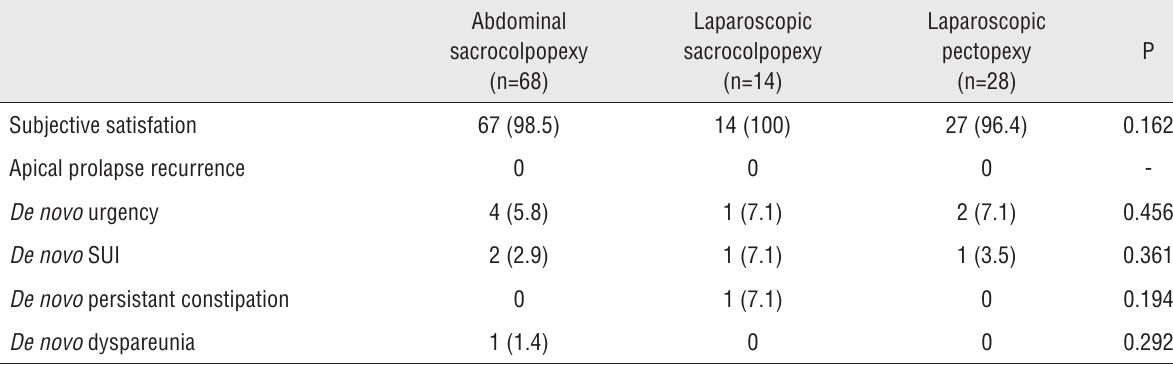
Table 4 - Short-term follow-up outcome in the study